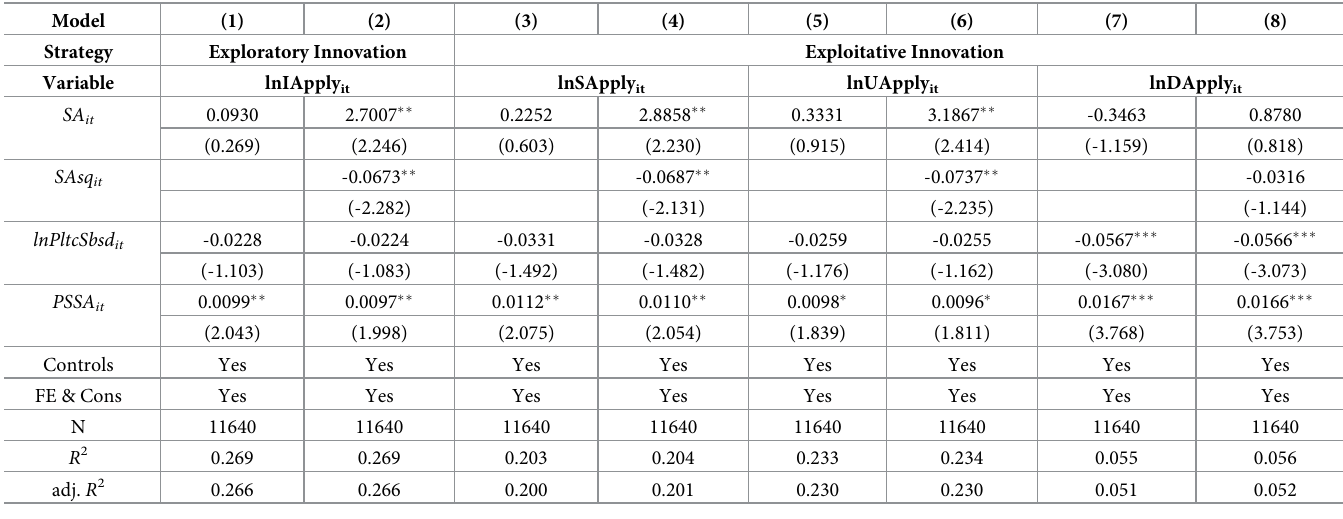
Table 7. Main results of moderation tests on different innovation